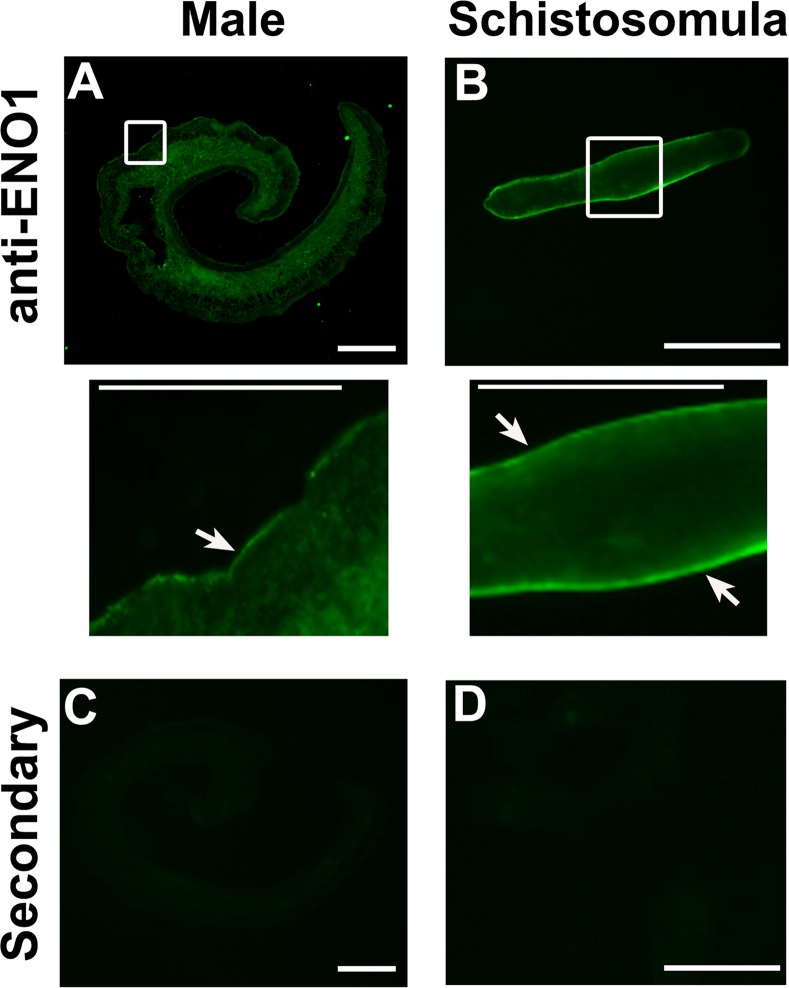
Immunolocalization of SmEno in S. mansoni adult worms and schistosomula.Indirect immunofluorescent labeling of native SmEno protein in sections of (A) an adult male and (B) a whole fixed schistosomulum using polyclonal anti-ENO1 antibody (and secondary anti-rabbit IgG antibody conjugated to Alexa 488 (green)). Enlargements of the areas shown in white boxes in the top row are presented in the middle row. Arrows indicate clear tegumental staining. As a control, secondary antibody alone was used on sections of (C) adult males and (D), whole fixed schistosomula. Scale bars = 100 μm or 50 μm in insets (middle row).